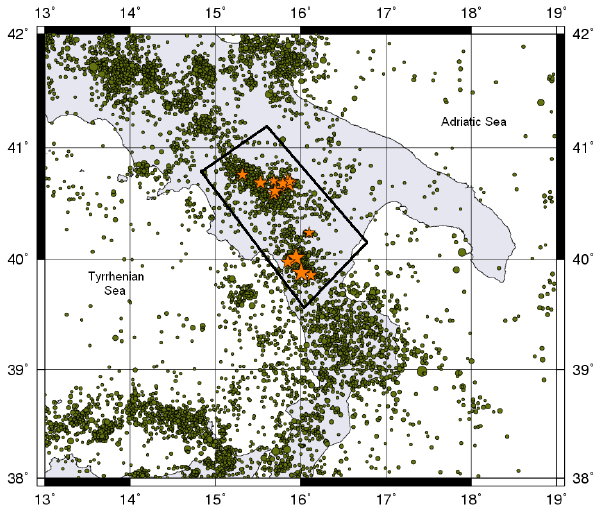
Figure 2. Seismicity map of Val d’Agri area and surrounding in the period 1983–2013 (Rectangle denotes the limits of the study area. Solid stars show the strong earthquakes, M L ≥ 4 . 0).